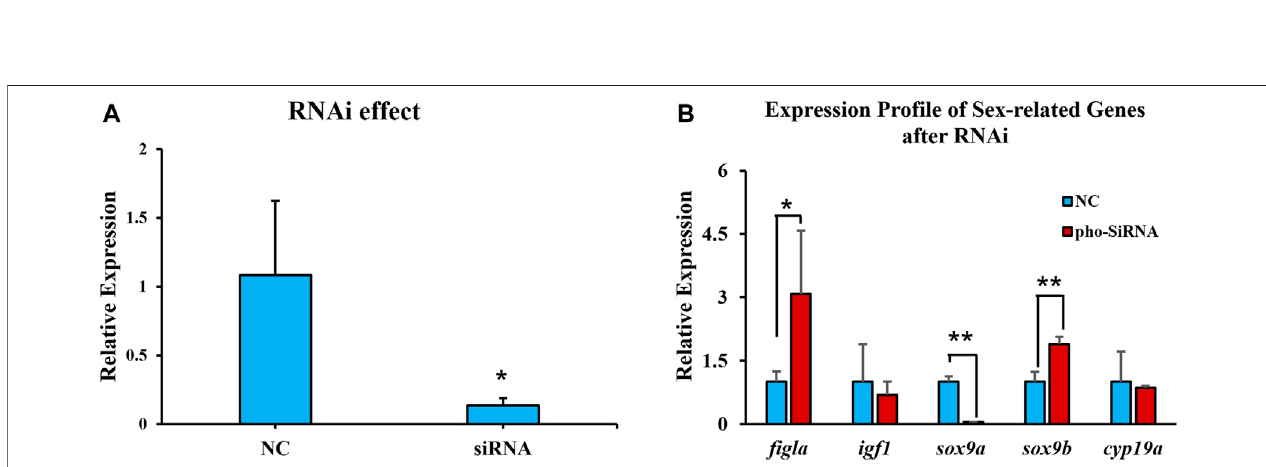
FIGURE 4 | Cellular localization of pitp β _w in the ovaries. (A – C) ISH in the 6 mph ovary with antisense probes corresponding to 40 ×, 100 ×, and 200 × magni fi cation; enlarged areas are highlighted by a red frame; (D) ISH in the 6 mph ovary with sense probes; (E – G) ISH in the 1 yph ovary with antisense probes corresponding to 40 ⅹ , 100 ⅹ , and 200 ⅹ magni fi cation; enlarged areas are highlighted by a red frame; and (H) ISH in the 1 yph ovary with sense probes. Oocytes at different developmental stages are marked by I, II, III, and IV. Scale bars: 100 μ m.